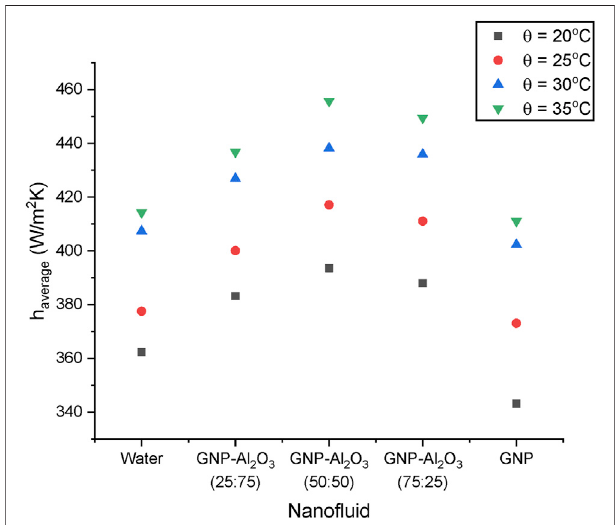
FIGURE 13 | The average heat transfer coef fi cient of the different nano fl uids at different temperature gradients.